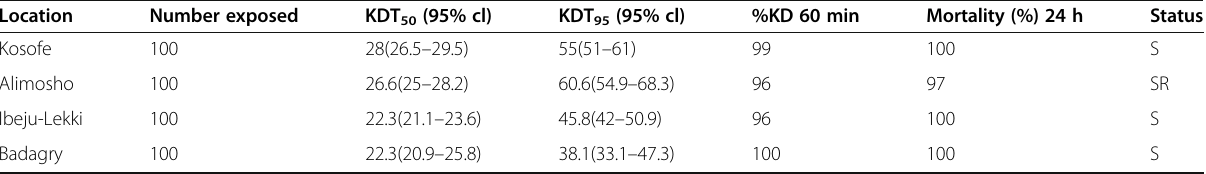
Table 2 The probit knockdown time (KDT 50 and KDT 95 ) values and percentage mortality of mosquito exposed to bendiocarb (0.1%) in Lagos State,